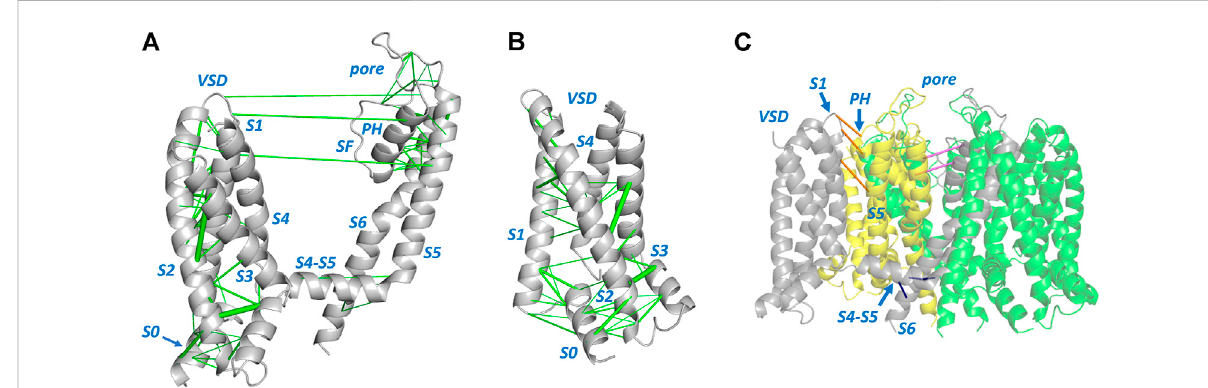
FIGURE 1 Evolutionarily coupled amino acids in the KCNQ1 channel membrane domain. (A) A single channel subunit from PDB:6V00 (Sun and Mackinnon,2020)isshownwithevolutionarilycoupledpairsofaminoacidsrepresentedbygreenlinesconnecting C α atoms[lineweightrepresents probability of EC pair (Hopf et al., 2019)]. (B) View of the KCNQ1 voltage sensor domain (VSD) illustrating EC interactions that link residues in the S0 helix with residues in helices S1 and S2. (C) Long distance EC interactions between residues within a single subunit (A) that are short range whenmappedbetweentheequivalentresiduesonadjacentsubunits,e.g.,betweenVSDandporedomainsofadjacentsubunits(orange),orbetween residues in adjacent pore domain subunits (pink). (C) also highlights EC interactions (blue) between residues in the long S4-S5 linker and S6 helix of the same subunit that are found in channel proteins with domain-swapped membrane subunits. SF: Selectivity Filter; PH: Pore Helix. In all views the side of the channel domains facing the cytoplasm is at the bottom of the fi